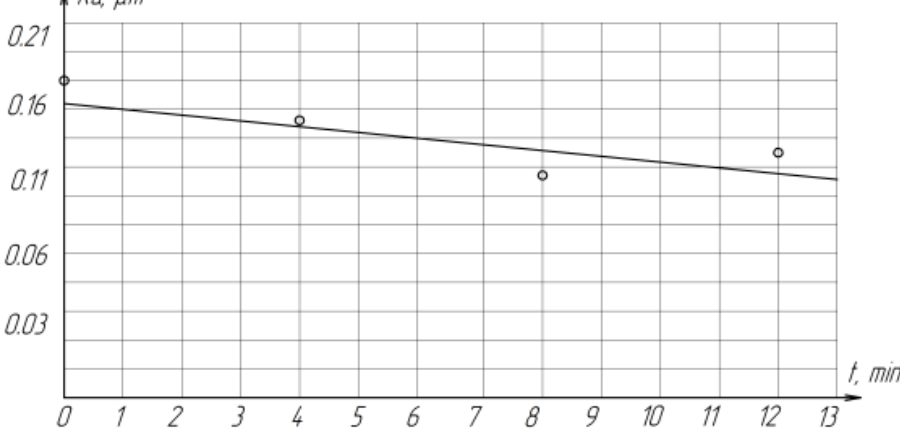
Figure 13. The effect of the total processing time T on the roughness of the treated surface of ZrO 2